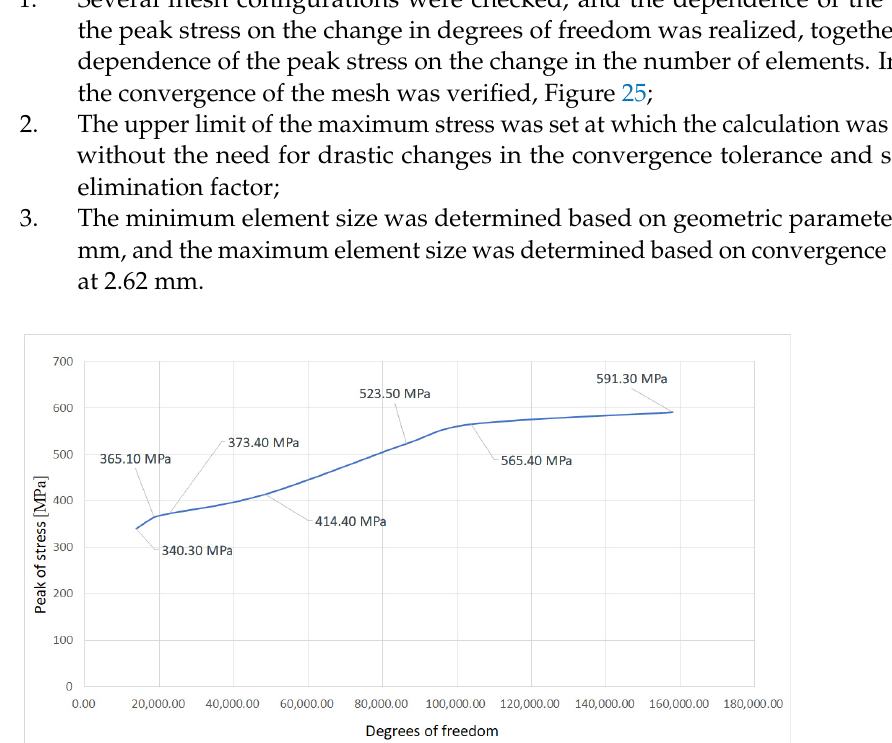
Figure 26. Typical stress distributions for the force ratio Fx:Fy = 1 using the von Mises condition of plasticity in the final step of the simulation. Purple arrows show the direction of the load; green arrows show the virtual action of the slider.